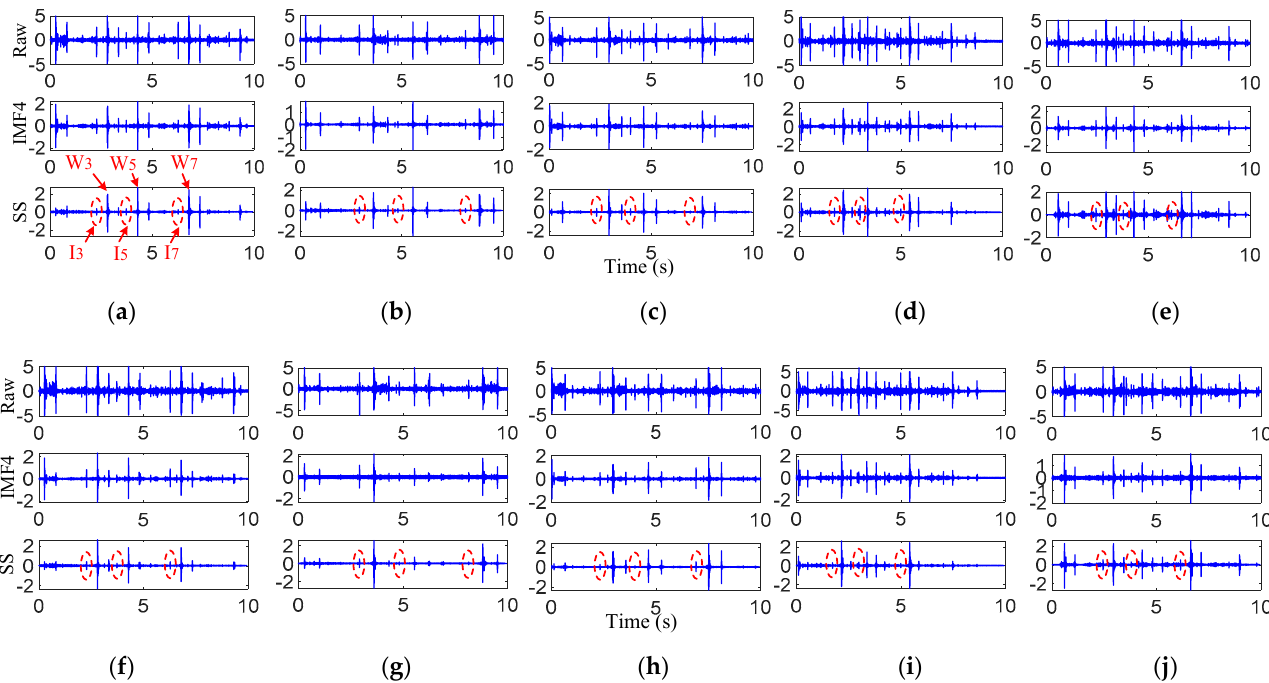
Figure 7. Vibration response of measuring point 1 under 17.1 km/h excitation.